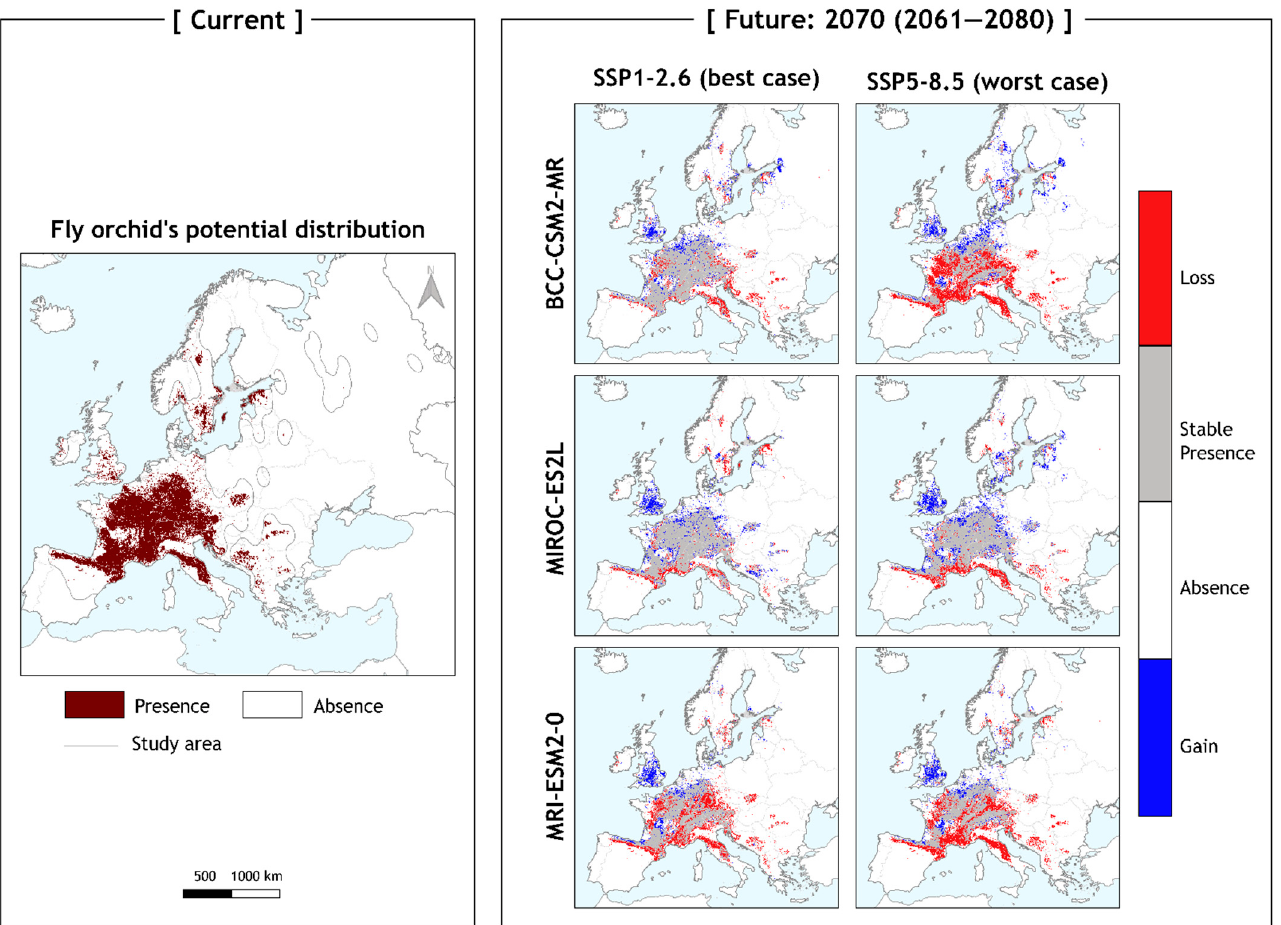
Figure 3. Current and future potential distribution maps for Ophrys insectifera EnvThin ensemble model. Left-hand panel: red-brown coloring indicates the cells the species currently potentially occupies. Each map is showing the transition from the present time-period to each respective GCM and SSP combination. Right-hand panel: future potential distribution maps of 2070 for the combinations of three GCMs (BCC, MIROC, and MRI) and two SSPs (SSP1-2.6 and SSP5-8.5) as ‘best’ and ‘worst’ case scenario. Grid cells with red coloring indicate the areas where the species is currently present but will not be in the future. Grey coloring represents cells where the species currently occupies and will continue to occupy in the future. White stands for the cells where the species is not currently present will not be in the future, while blue grid cells indicate the areas where the species is not currently present but will occupy in the future. All maps are designed in QGIS v.3.18 ‘Zürich’, using ETRS89—Lambert Conformal Conic Coordinate Reference System.